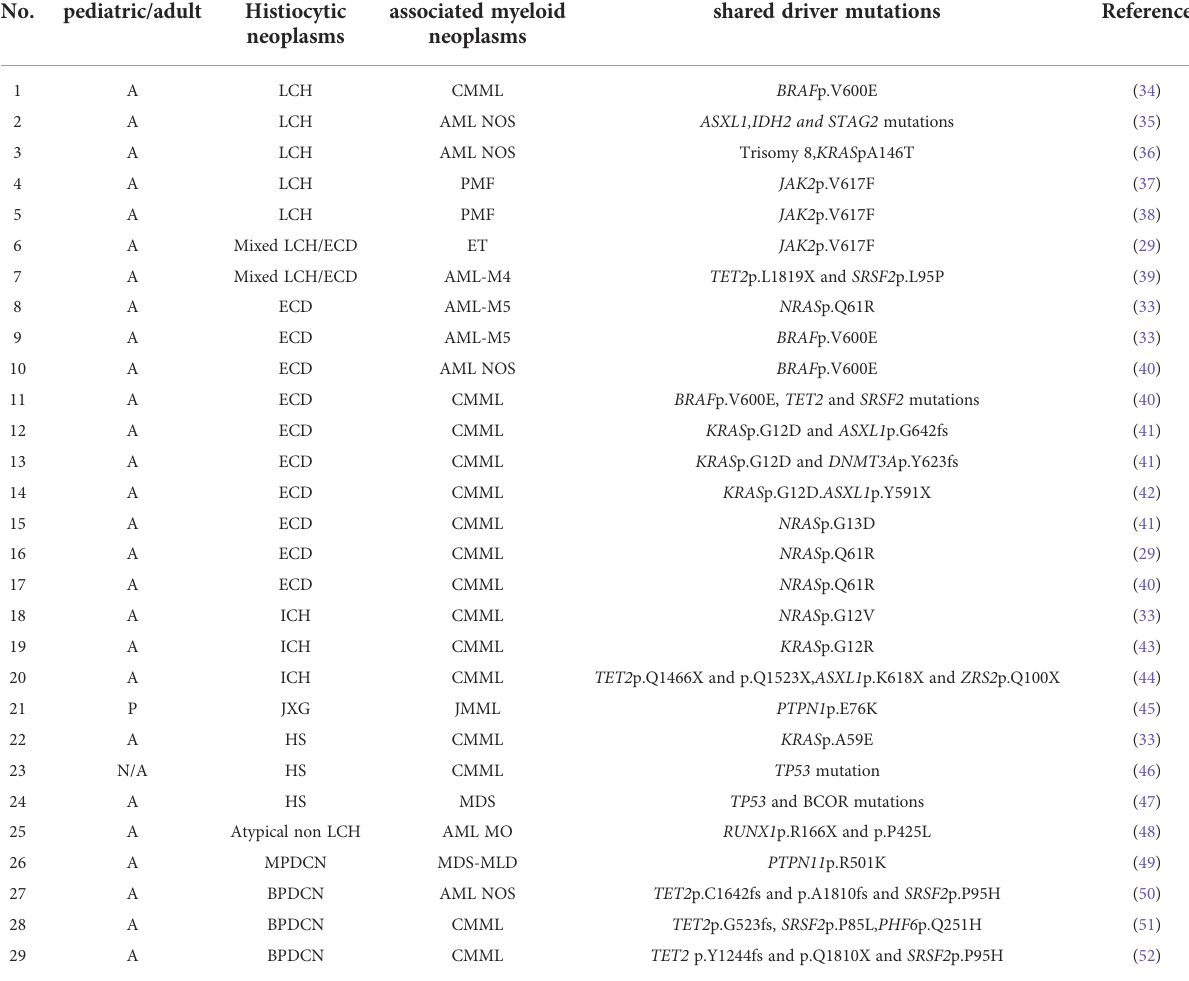
TABLE 2 Overview of reported cases with histiocytic disorders and additional myeloid neoplasms bearing the same genetic alteration(s).